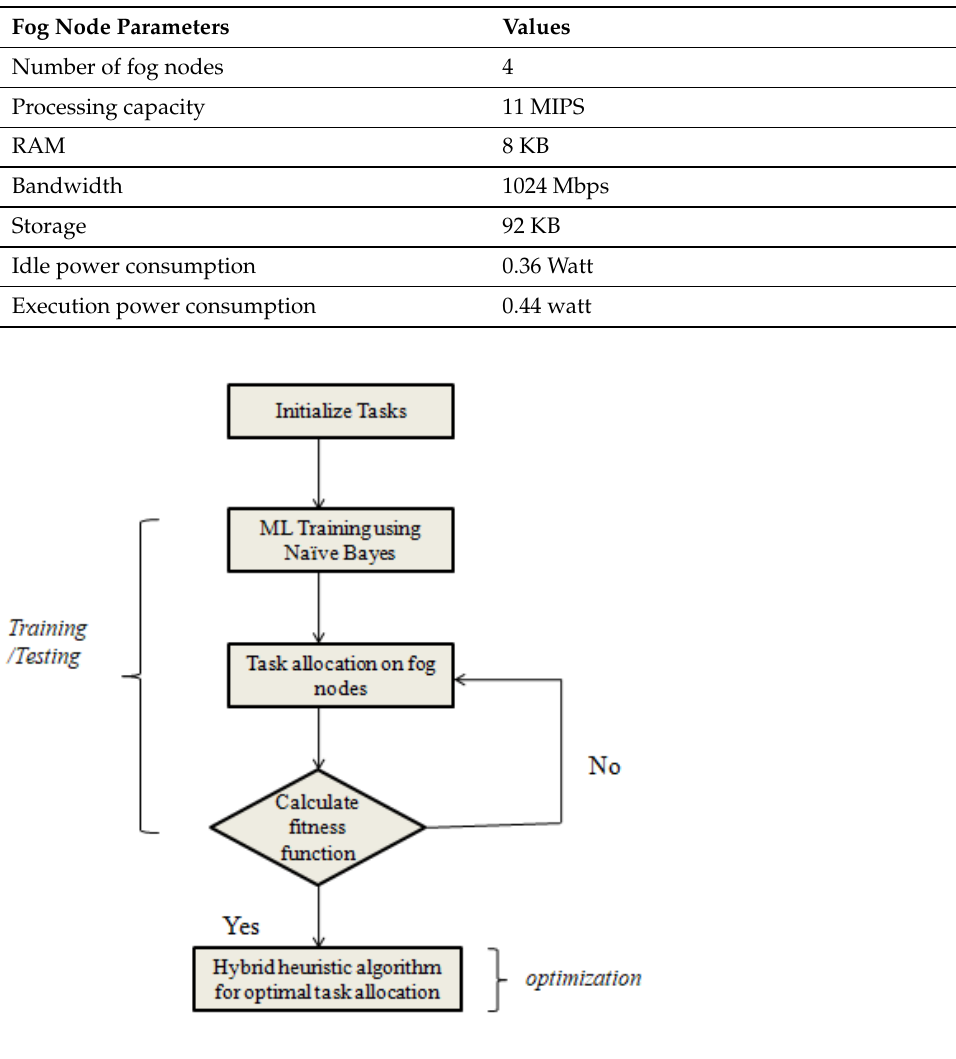
Figure 3. Data flow of the 2-stage task scheduling algorithm for optimal task